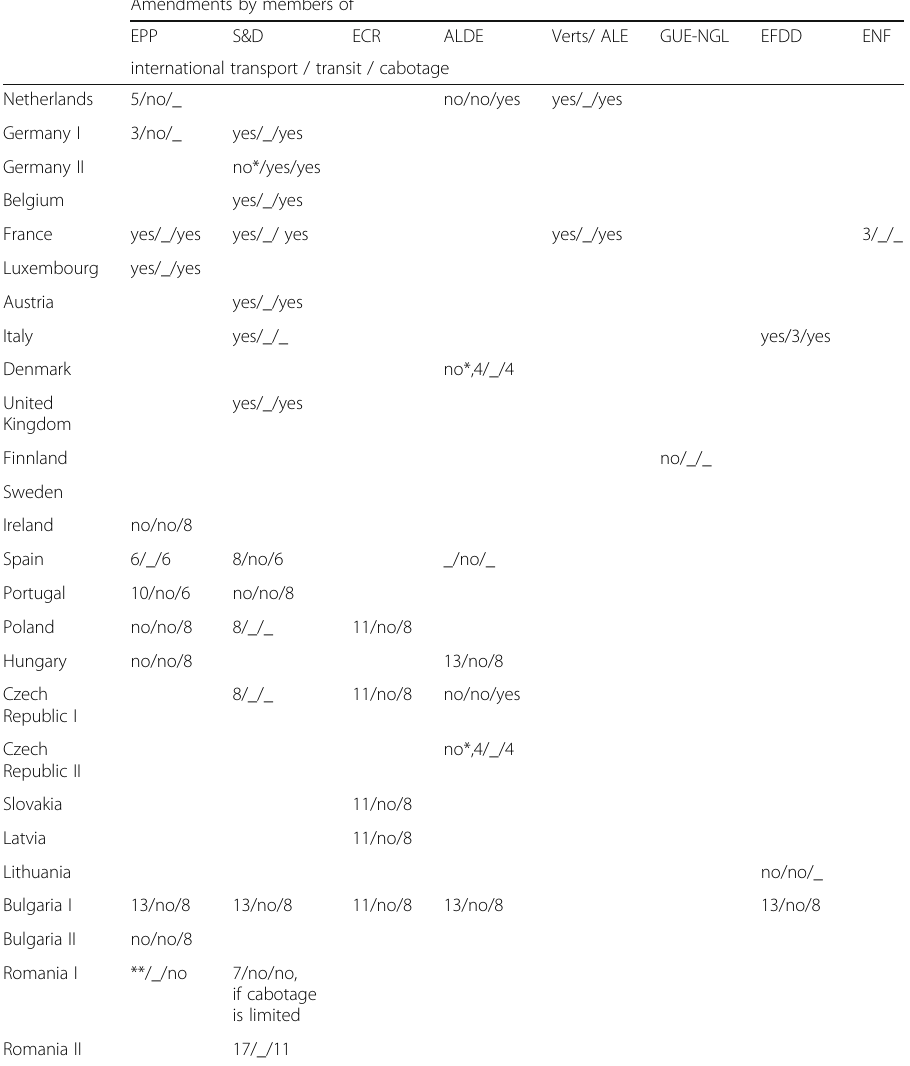
Table 3 Amendments regarding the application of the Posting of Workers Directive Amendments by members of EPP